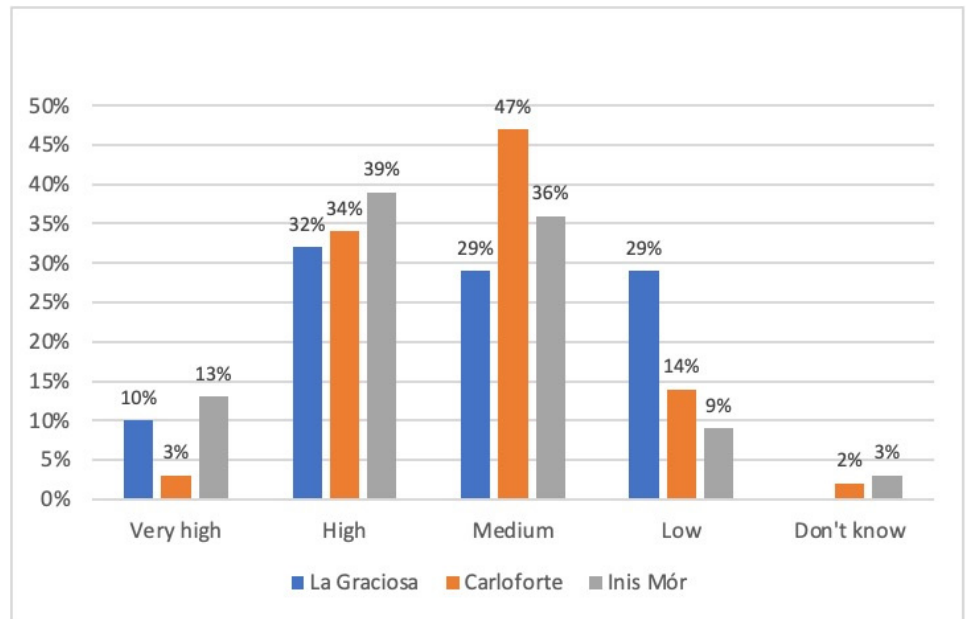
Figure 1. Impact of energy expenditure of households in the three islands.